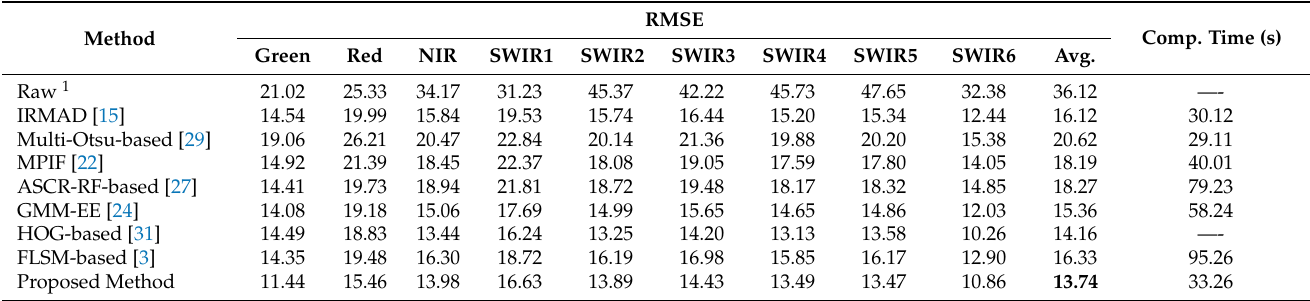
Table 4. Comparison between the accuracy and componential time of different SRRN methods and the proposed method for dataset